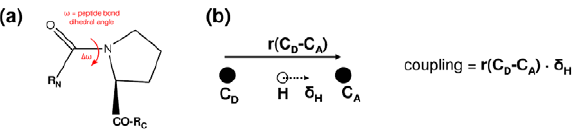
Figure 8. Definition of reaction coupling. (a) Coupling to the cis/ trans isomerization catalyzed by CypA, with v indicating the amide bond dihedral angle. For mode i , the coupling Dv is defined as: Dv i = v i + 2 v i 2 , where v + and v 2 are the two extreme ends of the displacement, computed by projecting the eigenmodes on the entire conformational ensemble. (b) Coupling to hydride transfer catalyzed by DHFR. r(C D –C A ) represents the position vector to acceptor carbon from donor carbon, and d H is the displacement vector associated with hydride in the